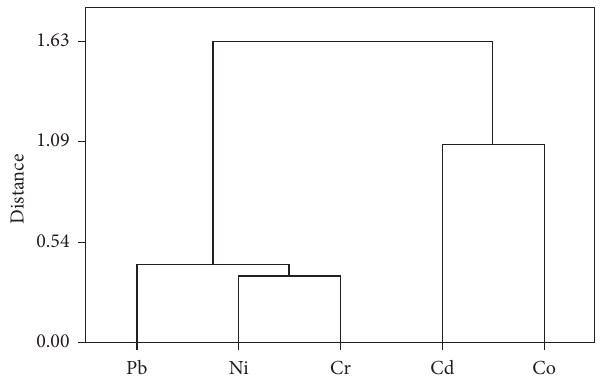
Figure 4: Dendrogram of the five heavy metals observed in the shallot fields (Ward’s